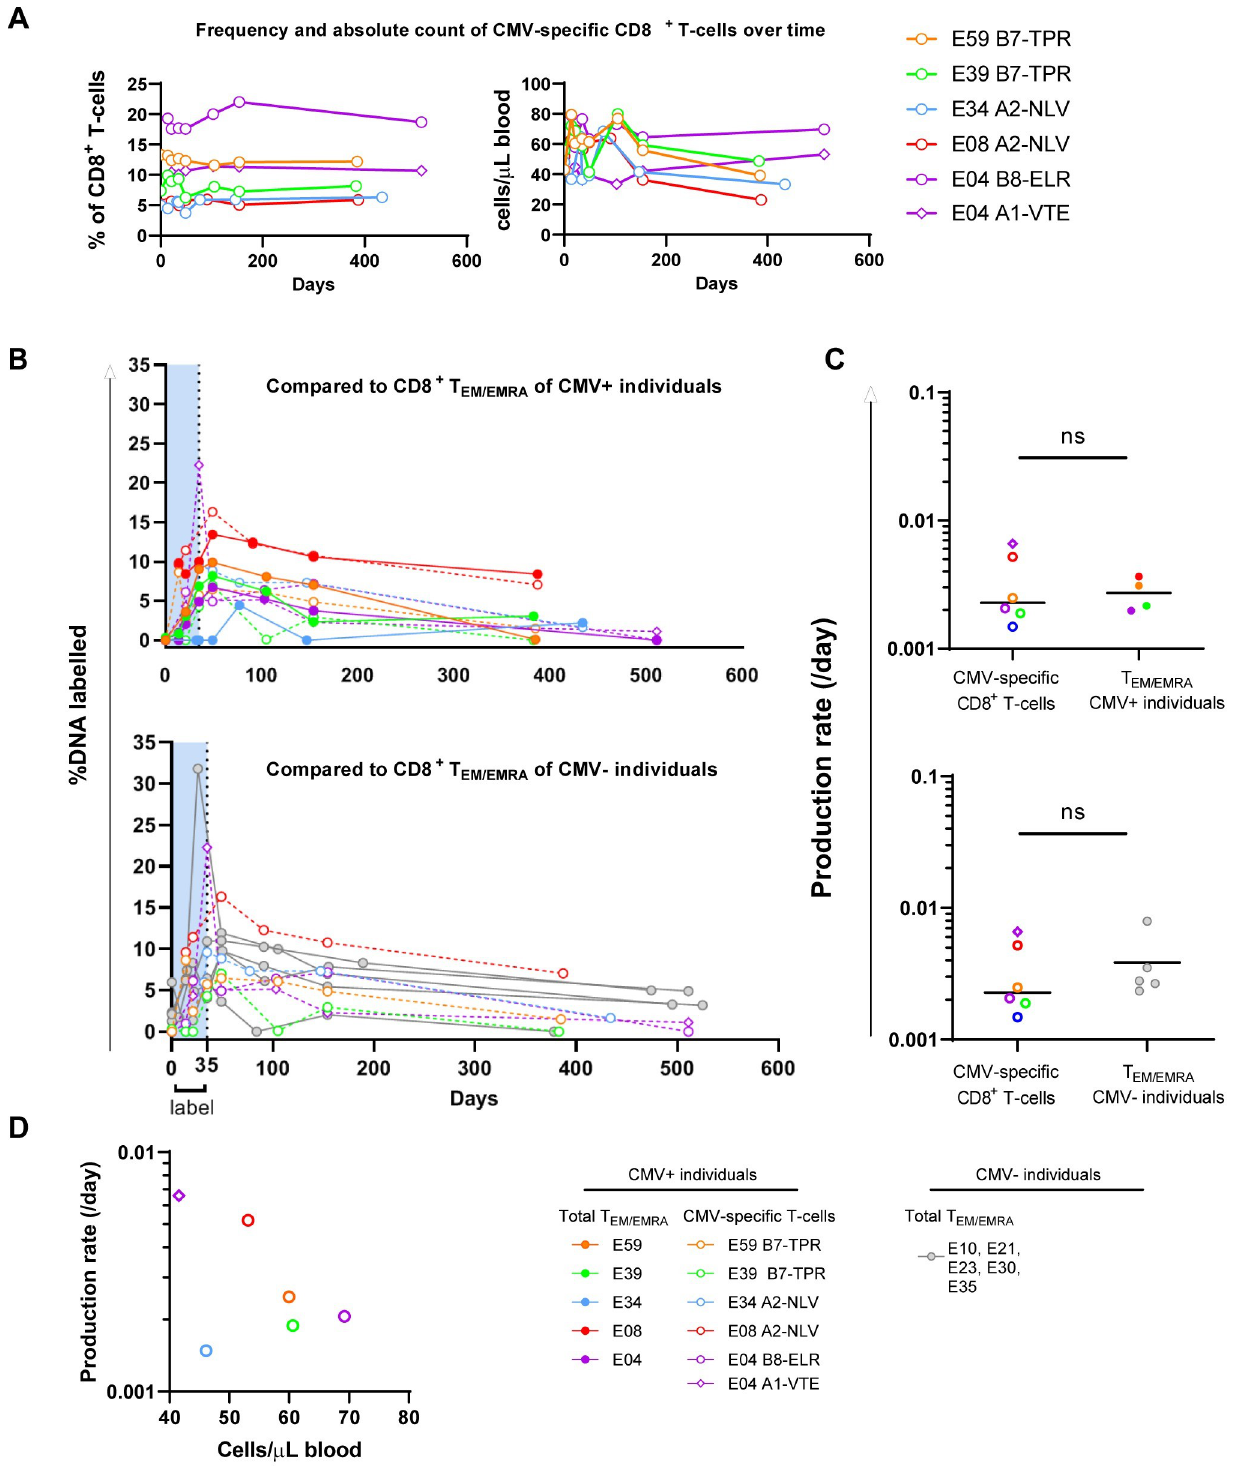
Fig 4. Dynamics of CMV-specific CD8 + T-cells and CD8 + T EM/EMRA cells in CMV+ and CMV- individuals. (A) Frequency within the total CD8 + T- cell pool (upper panel) and absolute count (lower panel) of CMV-specific CD8 + T-cells over time in the CMV+ individuals selected for the deuterium labelling study. (B) Deuterium labelling enrichment (%DNA labelled) of CMV-specific CD8 + T-cells compared to CD8 + T EM/EMRA cells of CMV+ (upper panel) or CMV- (lower panel) individuals. Label enrichment was scaled between 0 and 100% by normalizing for the estimated maximum enrichment